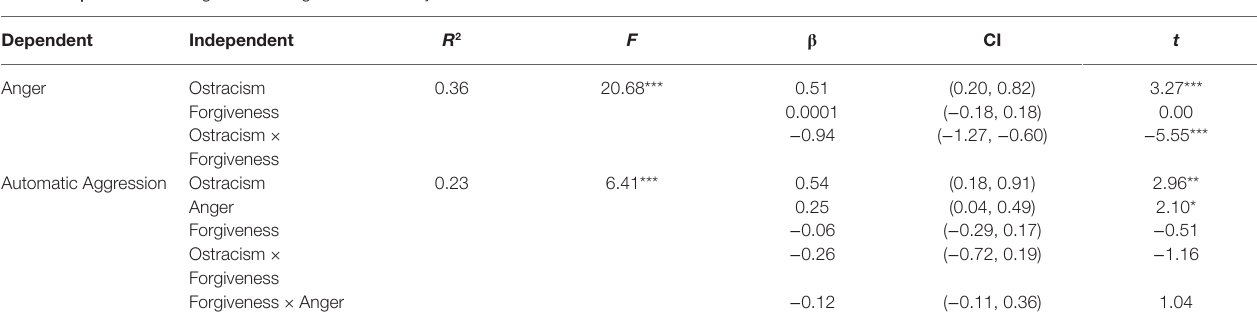
TABLE 2 | The moderating effect of forgiveness in Study 3.